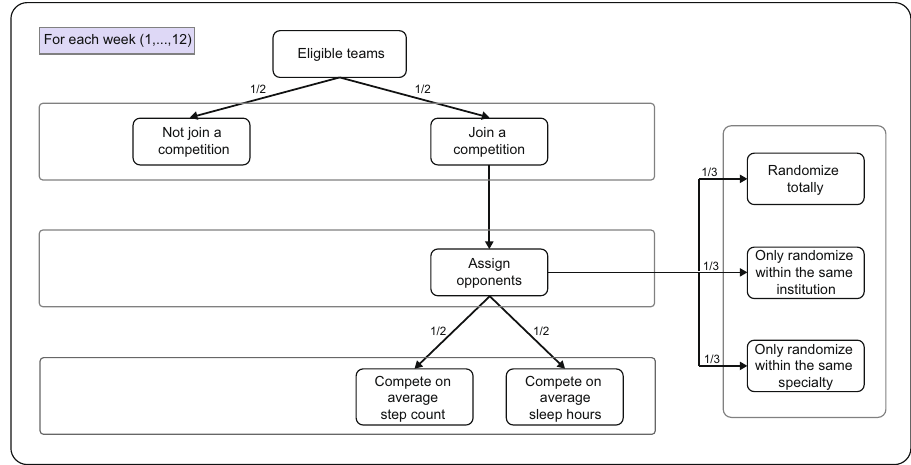
Fig. 2 Study randomization scheme. Flow diagram demonstrating the randomization scheme of Intern Health micro-randomized